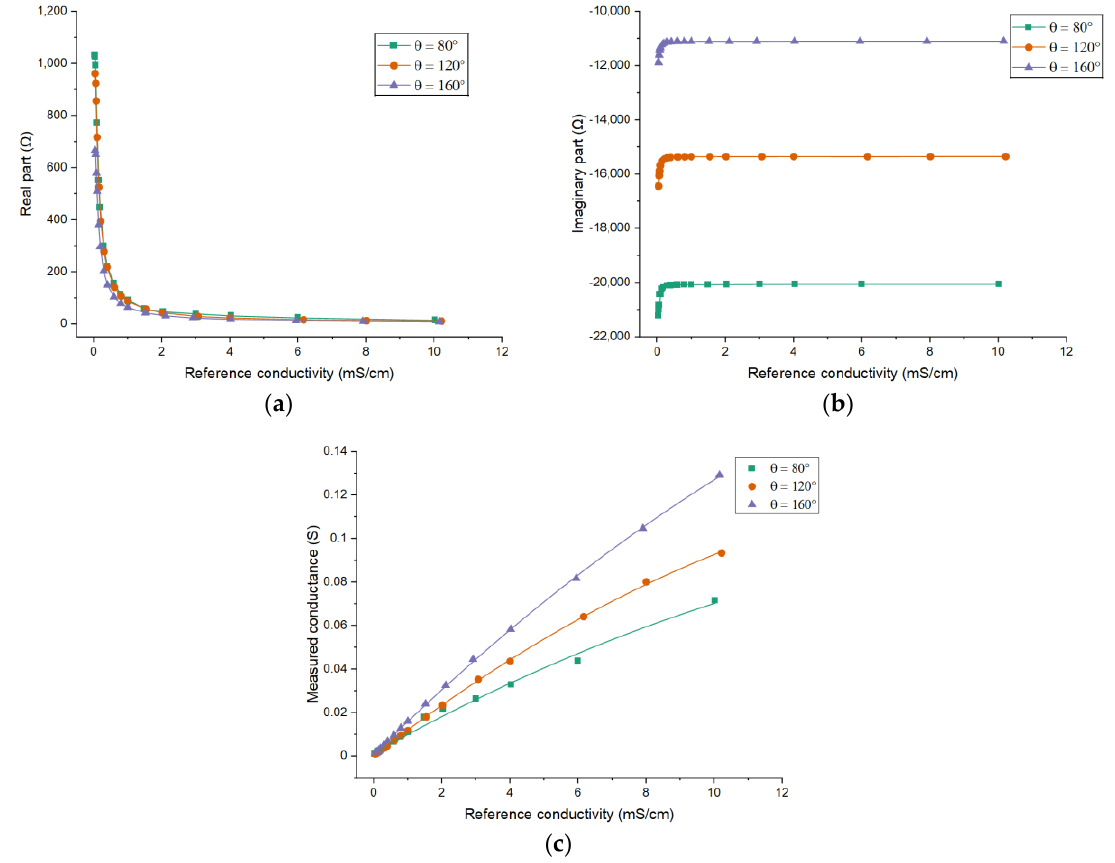
Figure 14. Experimental results for different electrode angles: The dependence of ( a ) the real part of the impedance; ( b ) the imaginary part of the impedance; ( c ) the measured conductance on the conductivity of the solution when L/d = 5.15.